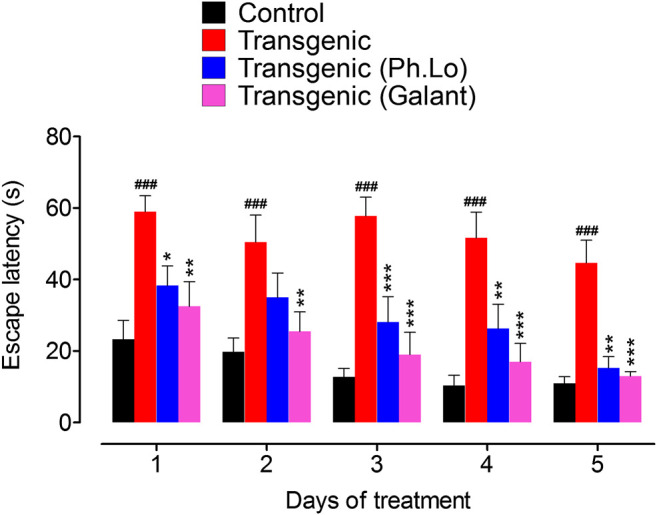
Results of the SWM test performed on various groups of animals. Each value represents an average ± SEM of three independent experiments. **, ##: p < 0.01; ***, ###: p s < 0.001. ns: values significantly different as compared to the normal group.